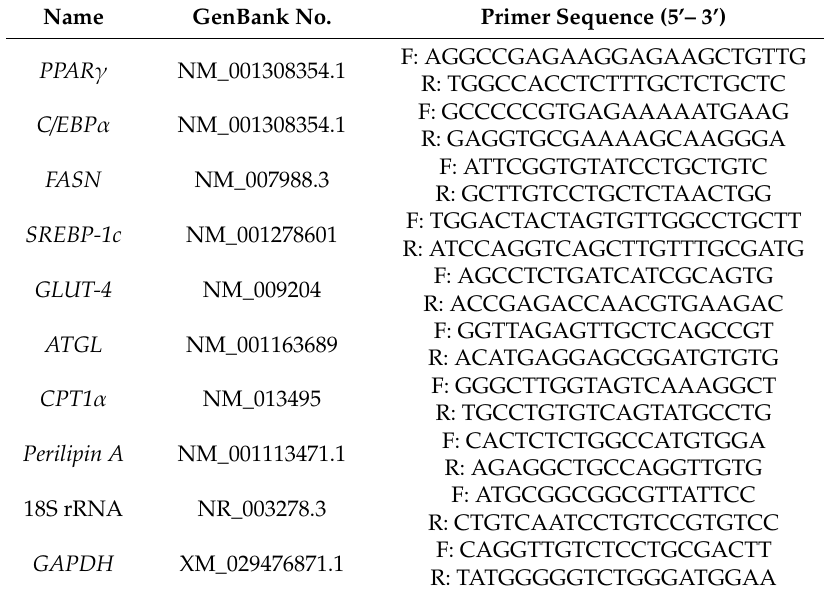
Table 1. Primers used for